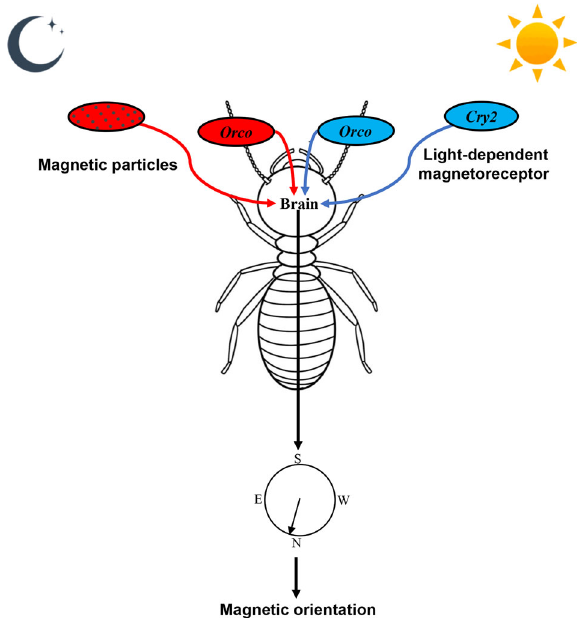
Fig. 7 The suggested model for termite orientation involved in magnetoreception mechanism. The termites exhibited directional preference under the GMF in white light and complete darkness. At the molecular level, GMF information is detected by termite Cry2 only in white light, however, GMF information is detected by magnetic particles in termites in complete darkness. In addition, Orco participated in termite magnetic orientation under both light and complete darkness. The joint action of Cry2, magnetic particles, and olfactory co-receptor in regulating magnetic orientation in fl uxgate magnetometer (FE-103, Huaming, CN, sensitivity: ±1nT) before each experiment.